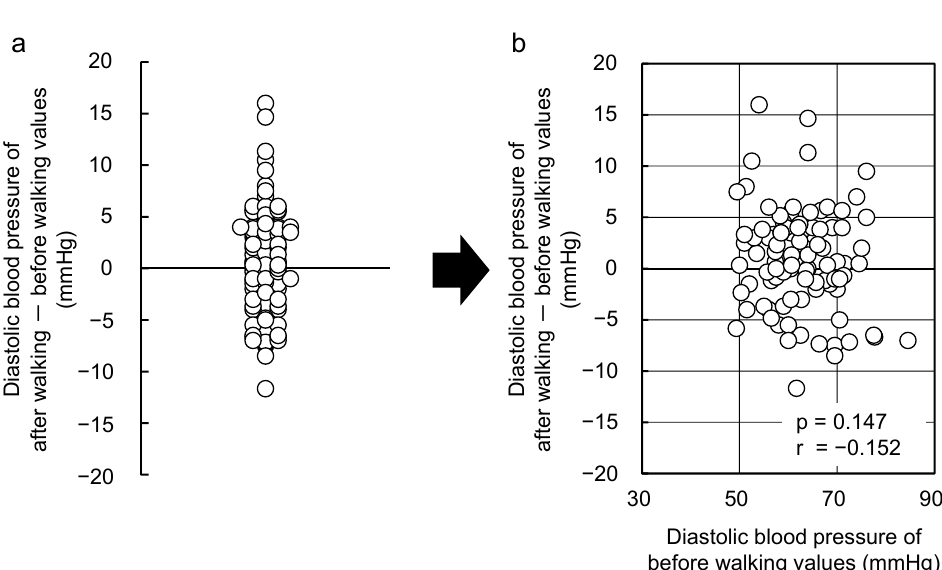
Figure 3. Changes observed with respect to walking in an urban area. Individual differences ( a ) and the relationships between the “initial value” and the “changes after walking in an urban area” ( b ) with respect to diastolic blood pressure ( n = 92). Pearson correlation test [70].